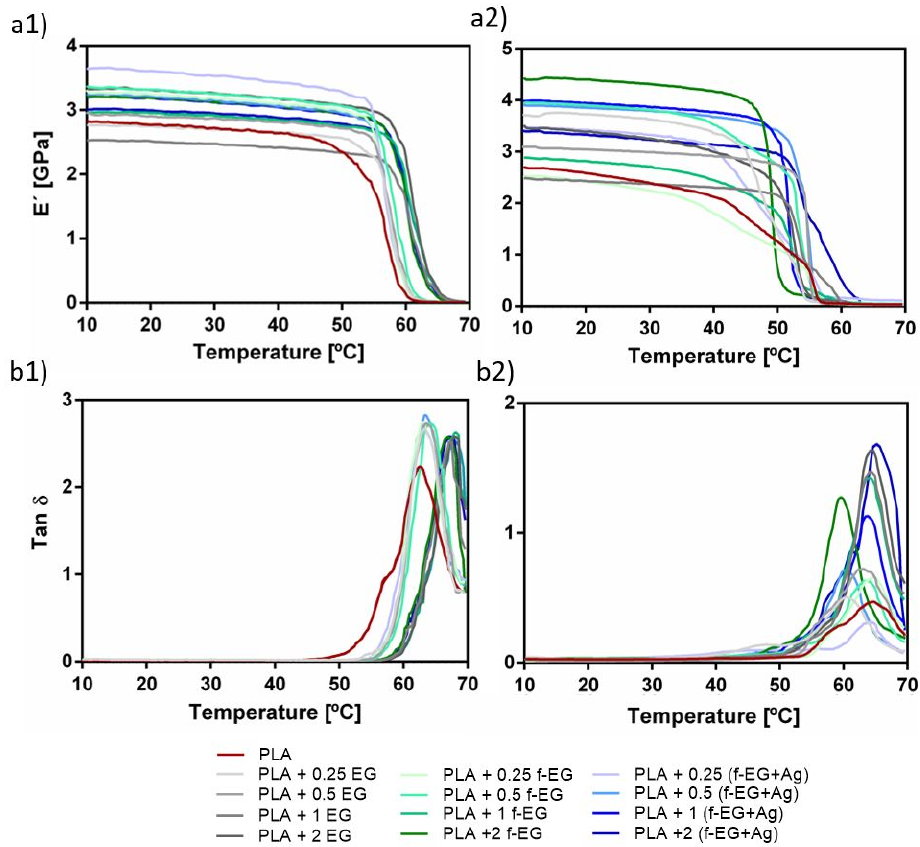
Figure 14. DMA spectra for the E’ of ( a1 ) Fil3D and ( a2 ) FilText, and tan σ of ( b1 ) Fil3D and ( b2 ) FilText, as a function of the temperature, ranging from 10–70 °C.